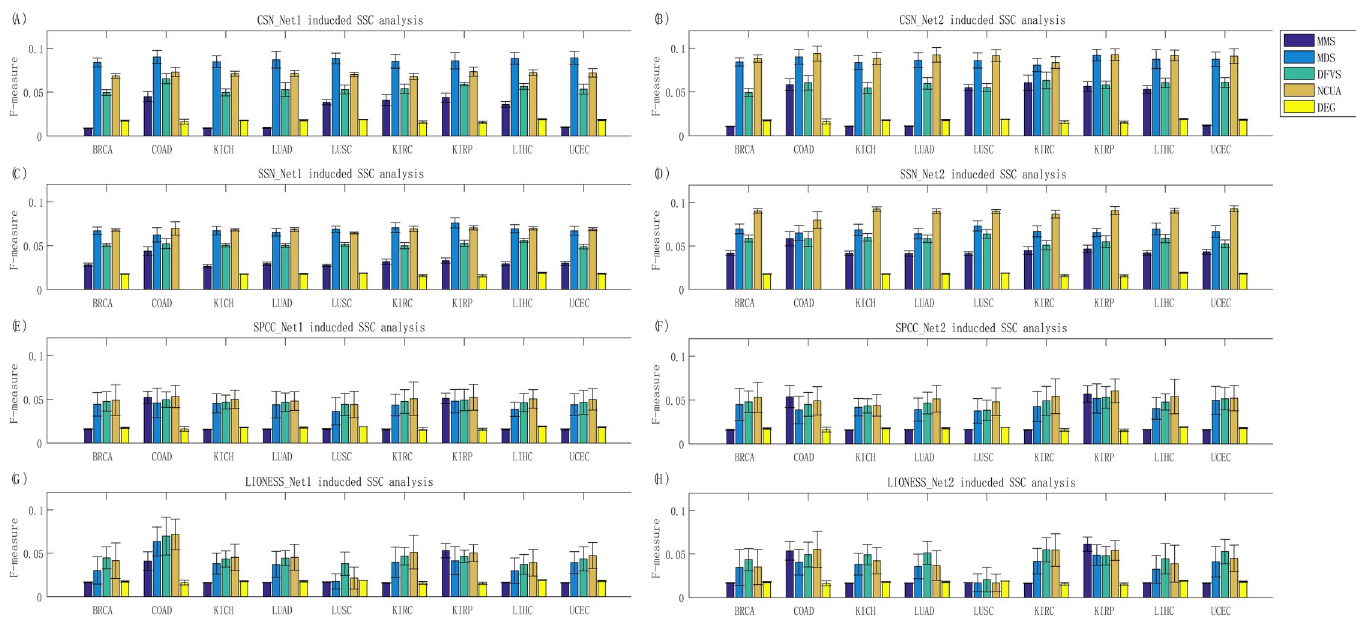
Fig 3. Evaluation of SSC workflows for driver gene identification on nine TCGA bulk cancer gene expression datasets. By using dissimilar combinations of sample- specific network and reference network, different sample-specific state transition networks can be obtained, e.g., (A) CSN_Net1, (B) CSN_Net2, (C) SSN_Net1, (D) SSN_Net2, (E) SPCC_Net1, (F) SPCC_Net2, (G) LIONESS_Net1, and (H) LIONESS_Net2. Then the performance of four network structural control methods based on these sample-specific state transition networks were evaluated, representing the performances of different SSC analysis workflows.